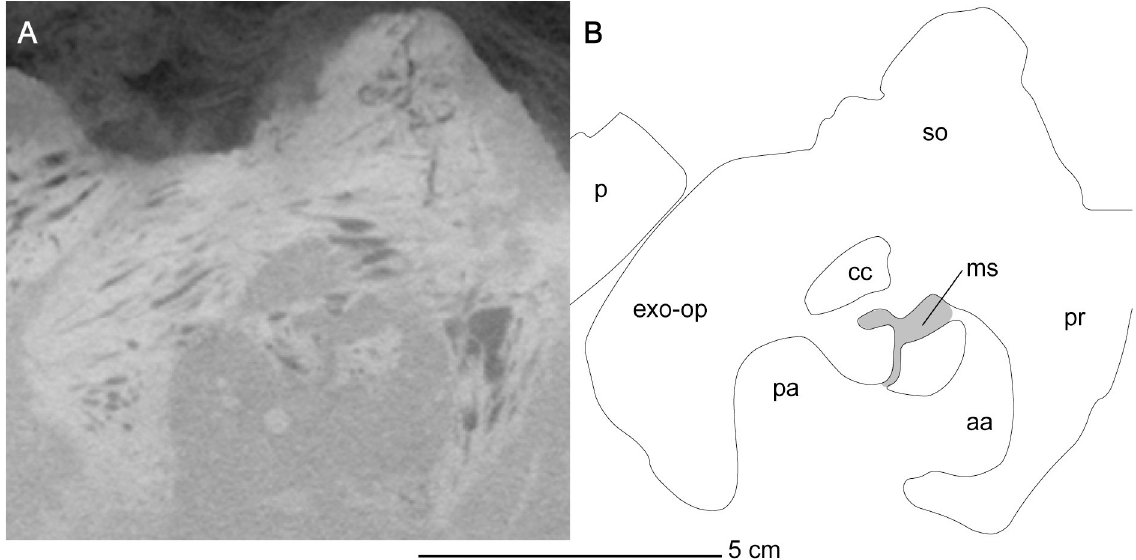
Fig 12. CT slice of the endosseous labyrinth of Cardiocorax mukulu (MGUAN PA278). Exposure of medial sinus expressed between the anterior and posterior ampullae.